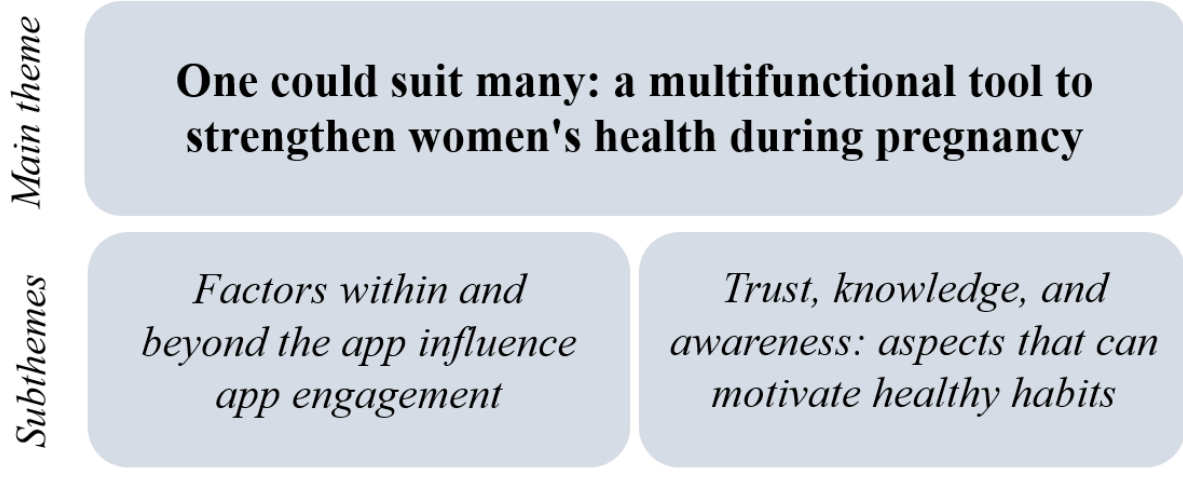
Figure 2. The themes identified in the thematic